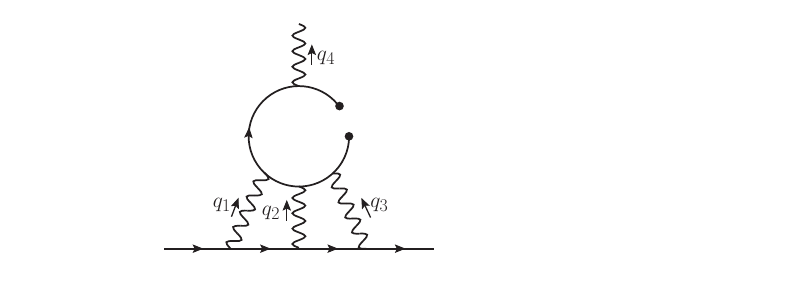
0 limit the quark propagator on !